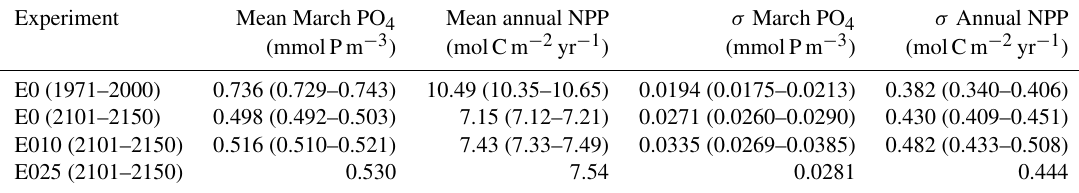
Table A1. Mean and standard deviation of pre-bloom (March) phosphate concentration and annual net primary production in the northern North Sea (see Fig. 4) during historical conditions as well as the shallow-ML regime for experiments without (E0) and with 0.1 (E010), and 0.25Sv GIS meltwater discharge. For E0 and E010, values refer to ensemble means with ensemble spreads given in brackets.